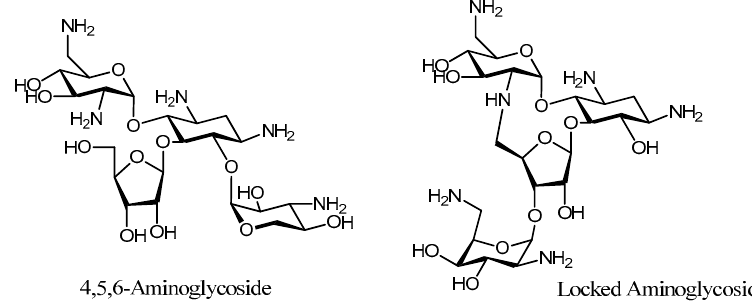
Figure 7. Structure of the 4,5,6-Neomycin derivative and constrained neomycin.